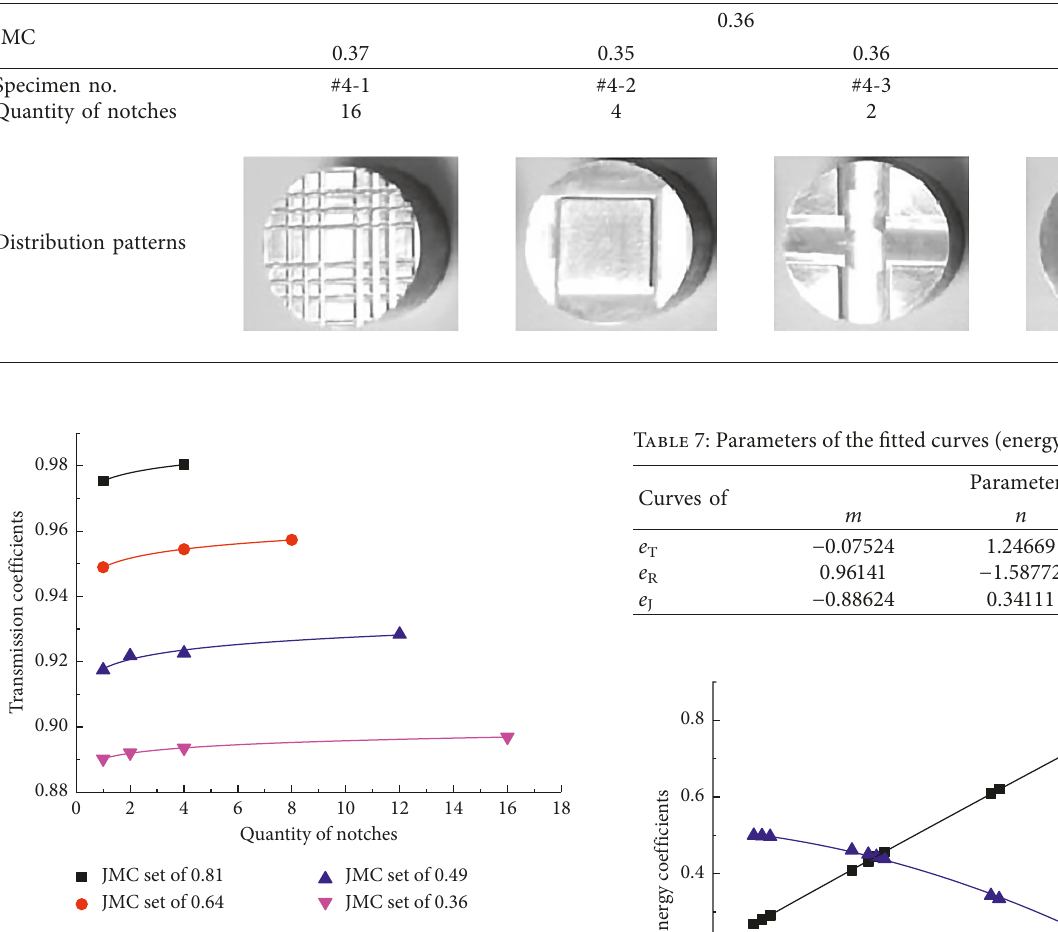
Figure 2: Relations of the geometrical parameters and trans- mission coefficients. Table 6: Parameters of the fitted curves (T-distribution pattern). Parameters